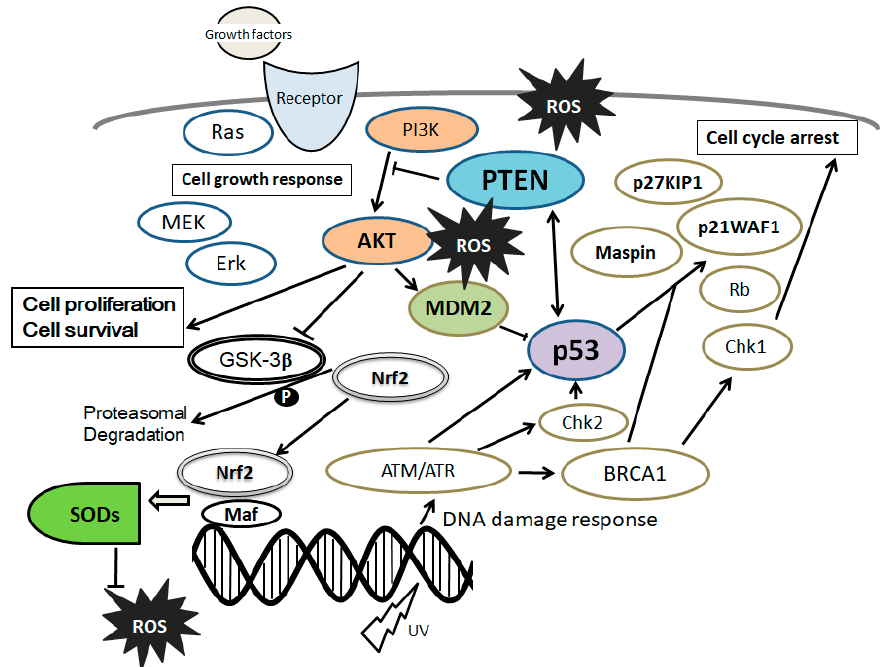
Figure 2. Schematic representation of the integrative model of tumor suppressor molecules signaling, including phosphatase and tensin homolog deleted on chromosome 10 (PTEN) and p53 in response to the extracellular growth factor stimulation and/or oxidative stress. Typical examples of molecules known to act on the DNA damage response and cell proliferation or cell cycle progression via the regulatory intracellular pathway are shown. Note that some critical signaling has been omitted for clarity.